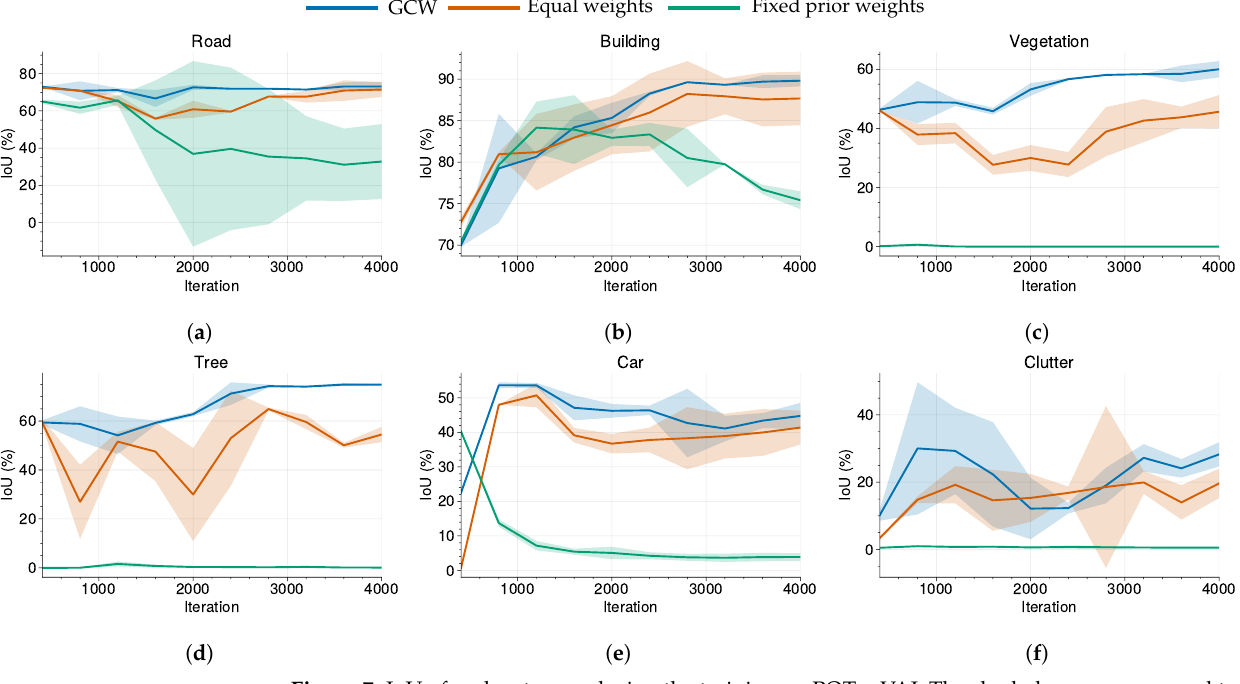
Figure 7. IoU of each category during the training on POT → VAI. The shaded areas correspond to the 95% confidence intervals. ( a ) Road. ( b ) Building. ( c ) Vegetation. ( d ) Tree. ( e ) Car. ( f )